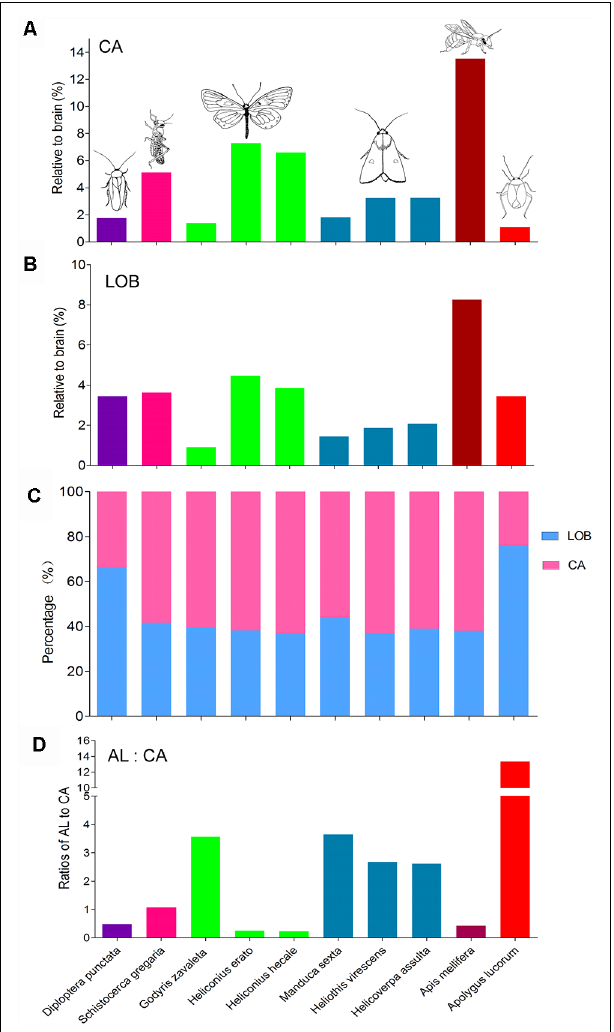
FIGURE 8 | Comparison of relative sizes of the calyx and lobes in different species. (A) Relative sizes of the calyx to the whole brain in different species. (B) Relative sizes of the mushroom body lobes to the whole brain in different species. (C) Proportion of calyx and lobes to the whole mushroom body. (D) The ratios of antennal lobe to calyx in different species. AL, antennal lobe; CA, calyx; LOB, mushroom body lobes including the